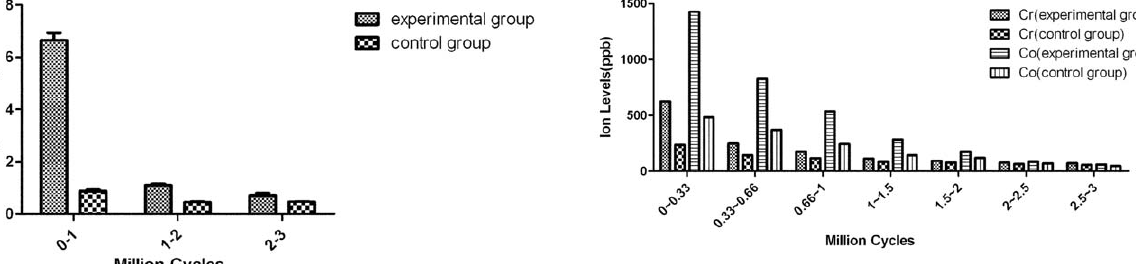
Table 3. Demographics of the cumulative volumetric wear of cups and heads.